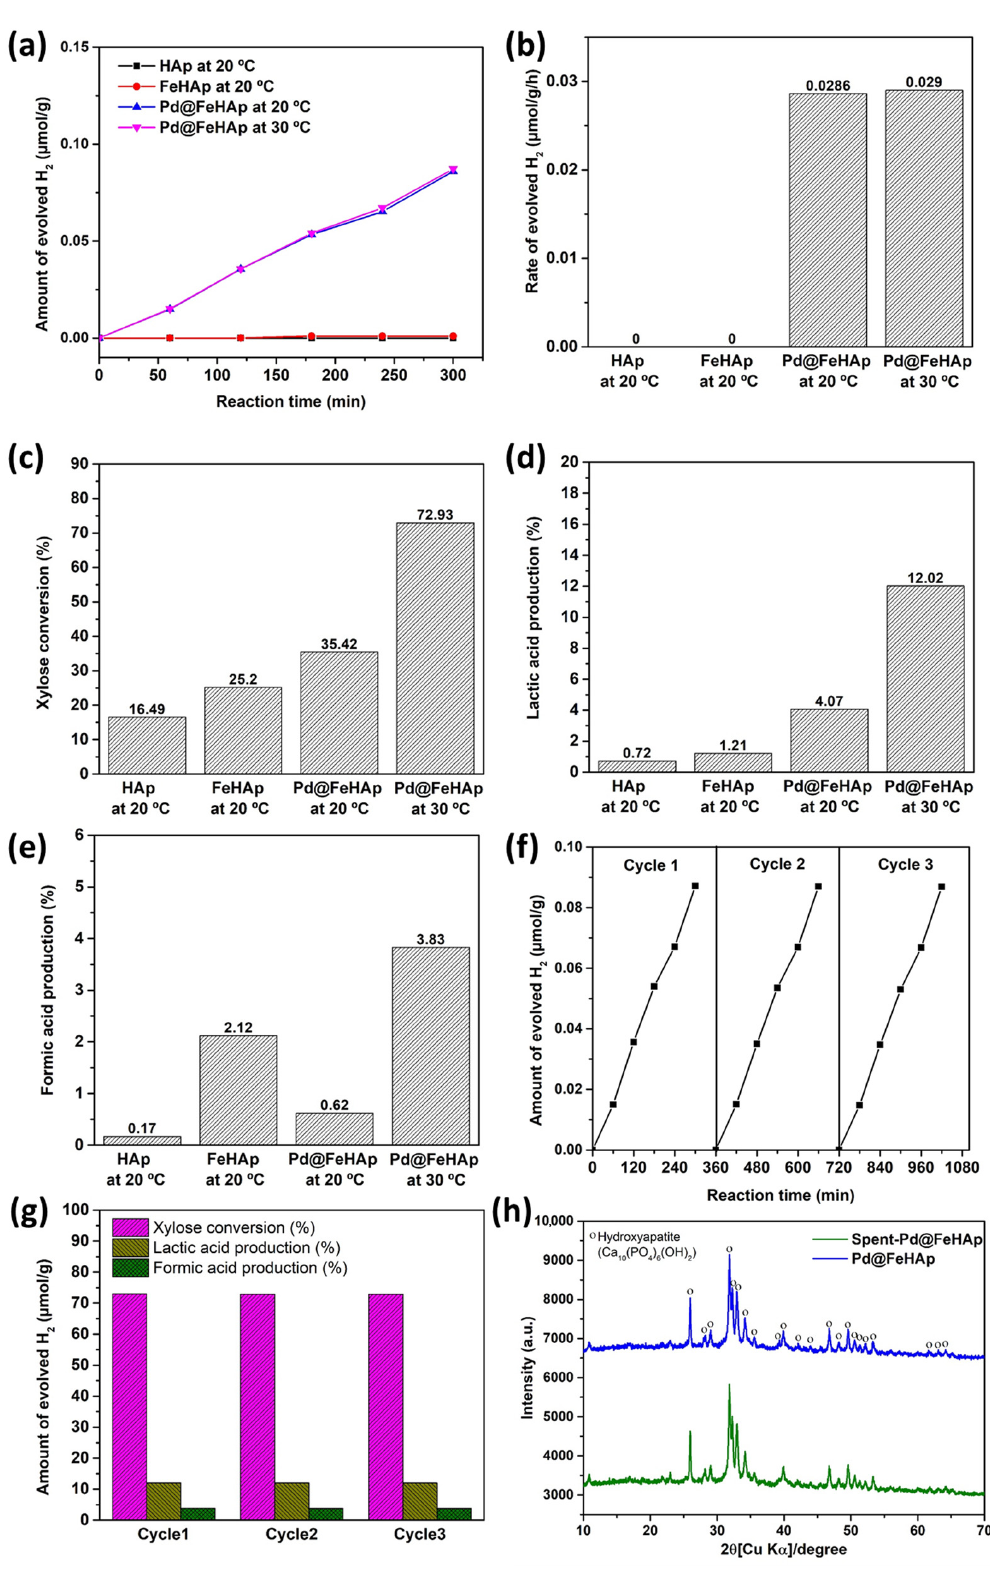
Figure 6. ( a ) Time course, ( b ) kinetics plots of photocatalytic H 2 production ( c ) xylose conversion, ( d ) lactic acid production, ( e ) formic acid production over HAp, FeHAp, and Pd@FeHAp, ( f ) reusability for H 2 over the Pd@FeHAp for 4 h, ( g ) xylose conversion and acid productions over the Pd@FeHAp for 4 h and ( h ) XRD patterns of fresh Pd@FeHAp and spent Pd@FeHAp after 4 h of the reaction.